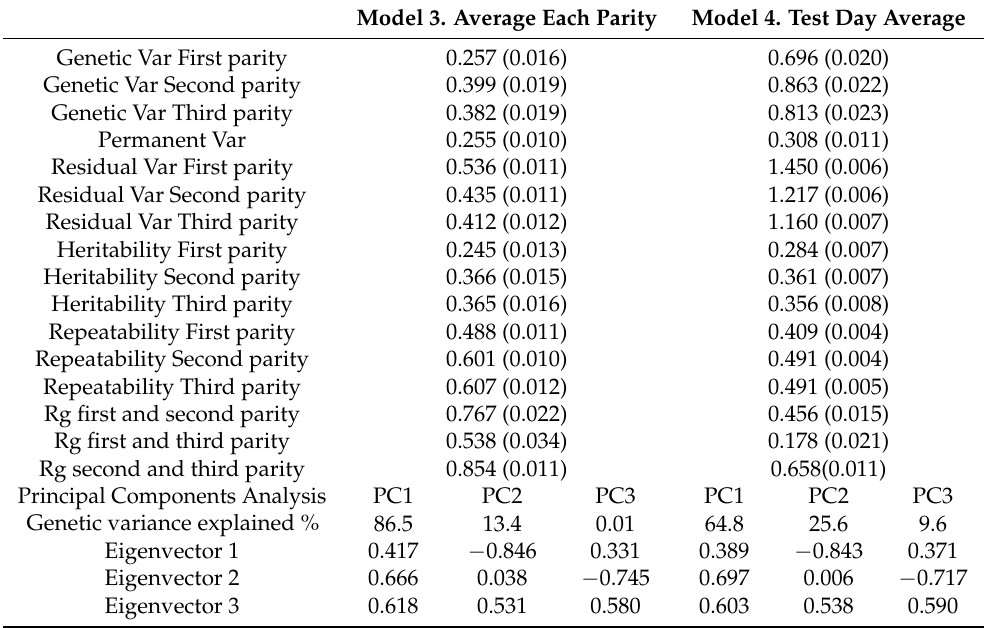
Table 3. Estimates of variance components, genetic parameters, and principal components of the genetic matrix for the average somatic cell score according to the multiple